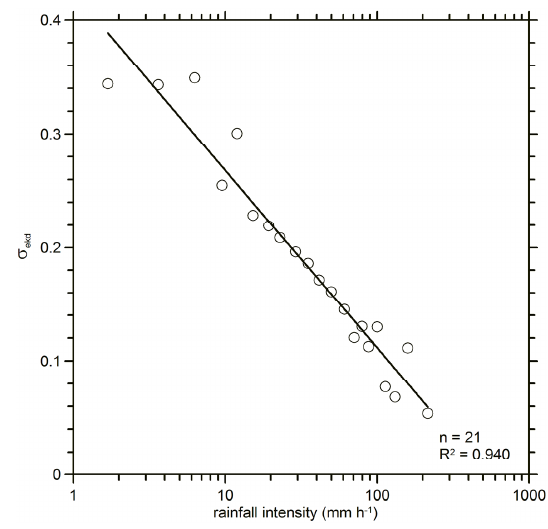
Figure 3. Fig. 3. Relationship between the standard deviation of the natural logarithm of the specific kinetic energy and the rainfall intensity obtained from the graphs listed in Table